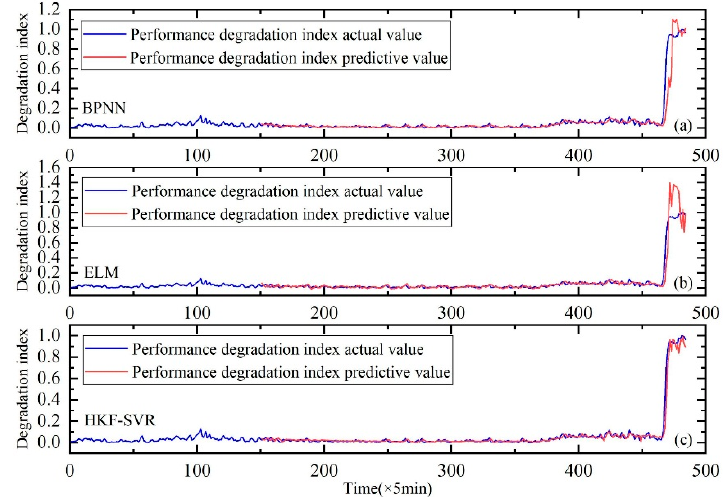
Figure 17. Performance degradation prediction of the rolling bearings. ( a ) is the result of BPNN, ( b ) is the result of ELM and ( c ) is the result of HKF–SVR with parameters optimized by the KH algorithm. Table 8. Prediction errors comparison. Table 7. Prediction errors comparison.